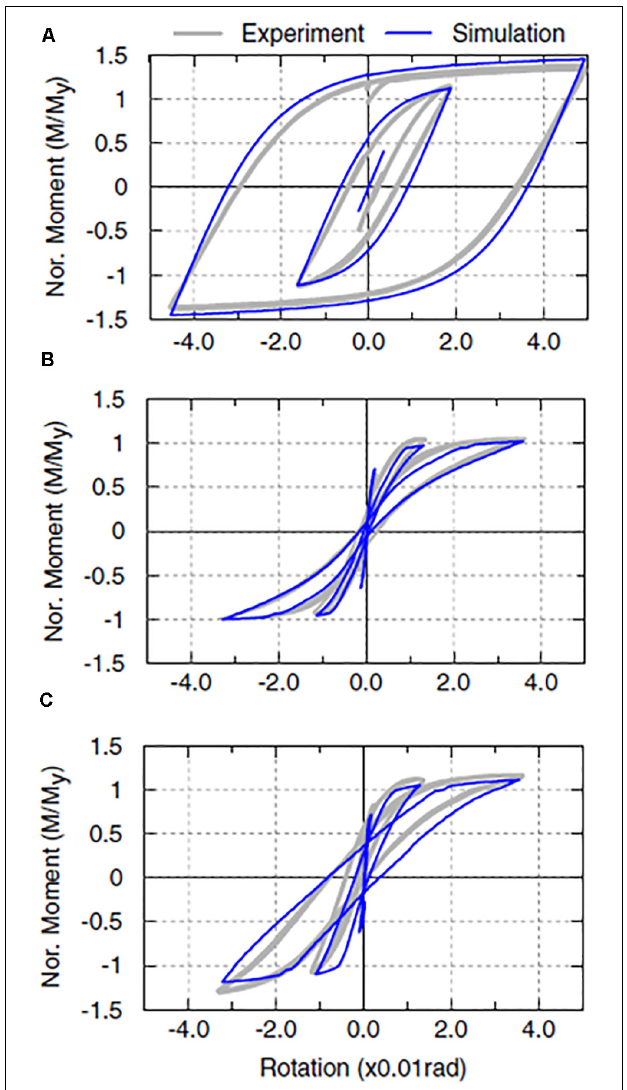
FIGURE 8 | Hysteretic response of inelastic elements in the sFRD model: (A) column fuse at level 2, (B) shear wall rocking footing, and (C) column rocking footing (Permission from Liu et al., 2015a with permission from ASCE).